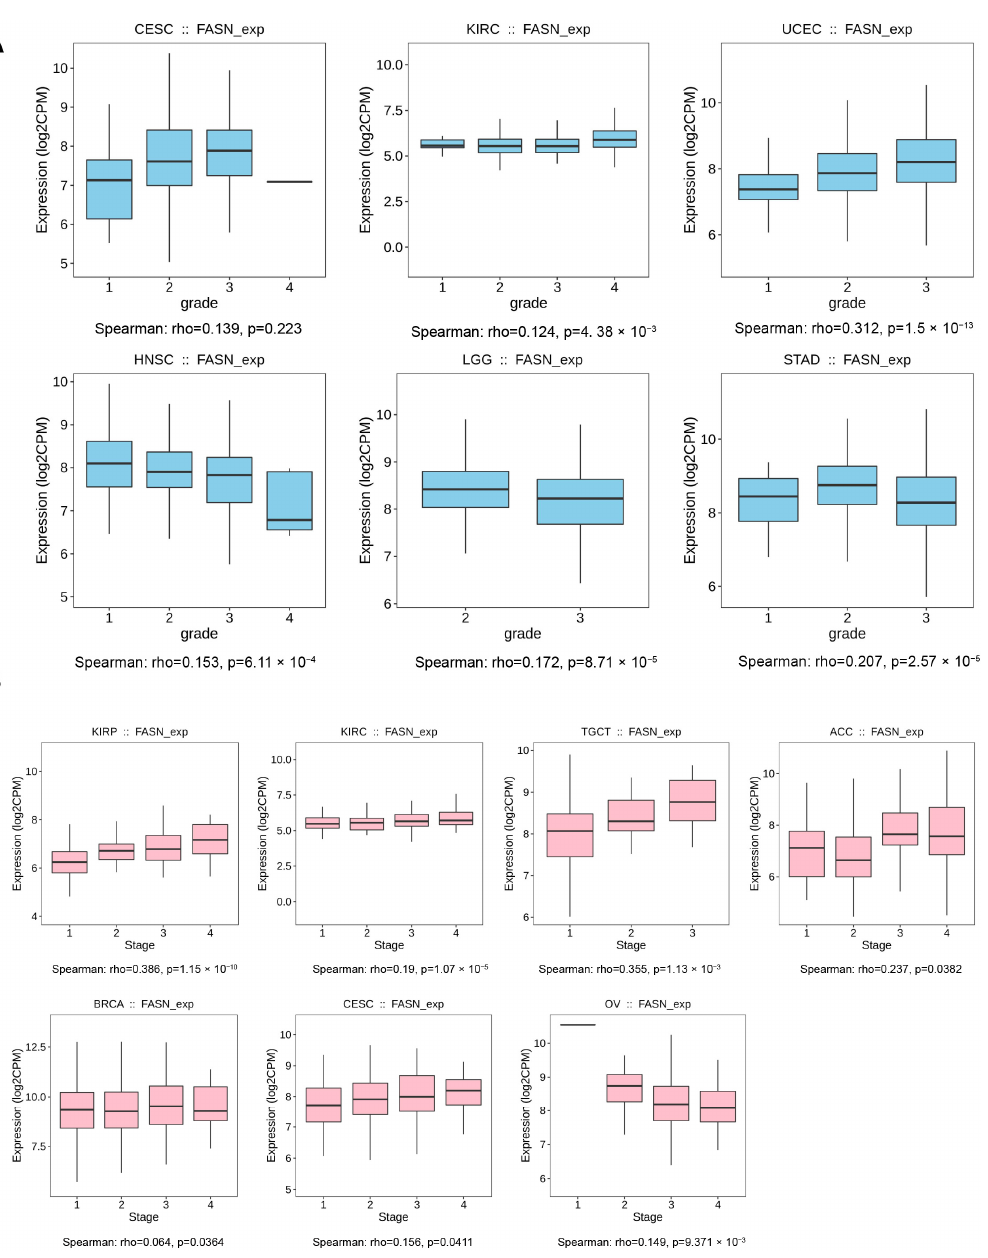
Figure 2. The correlation between FASN expression and cancer pathological grade. Grade ( A ) and stage ( B ) were analyzed by TISDB. FASN expression and progression grade and stages map with positive results are given ( p < 0.05).